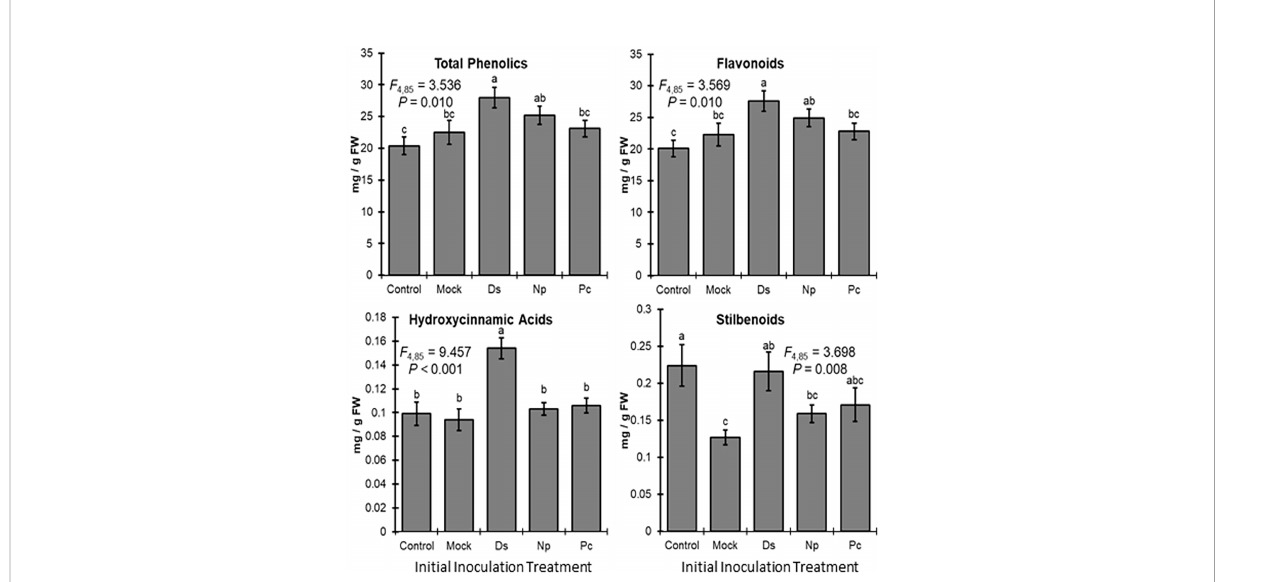
FIGURE 3 Mean phenolic compound levels (± SE) in the woody stem after the initial inoculation with: Control, NINW; Mock, NIW; Ds, Diplodia seriata ; Np, Neofusicoccum parvum ; Pc, Phaeomoniella chlamydospora . Differences among initial inoculation treatments are noted with different letters (statistical differences by least signi fi cant differences tests). Initial inoculation treatments are as follows (on the X axis): Control, NINW; Mock, NIW; Ds, Diplodia seriata ; Np, Neofusicoccum parvum ; Pc, Phaeomoniella chlamydospora